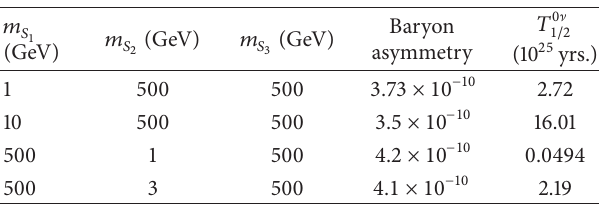
Table 4: Predictions for baryon asymmetry and double beta decay half-life as a function of sterile neutrino